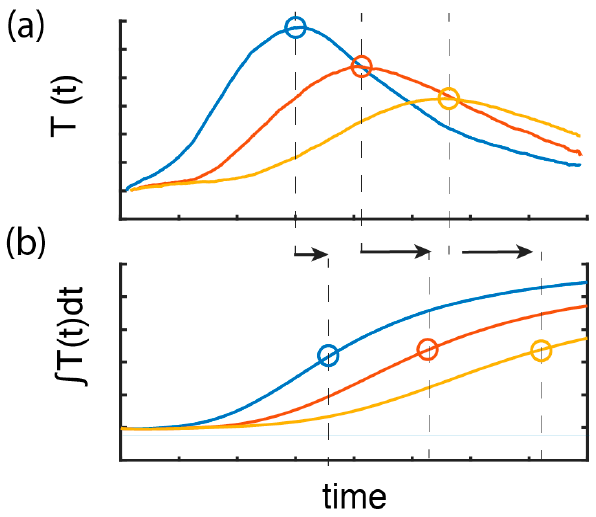
Figure 3. Description of two methods to estimate flow velocity. ( a ) Temperature profiles T ( x , t ) measured at three different fiber locations, indicating that the peak temperature can be tracked over the time–distance domain to extract the flow velocity. Convective heat transport distorts the symmetry of the heat pulse propagating downstream; therefore, this method results in a significant underestimation of the flow rates. ( b ) The integral of the temperature profile over time for three different fiber positions, from which the “center of heat” is obtained as the time when the integral of T ( x , t ) reaches half the maximum value for each position. Tracking this center point gives information of the propagation of the centroid of the thermal energy pulse. The black arrows highlight the difference between the identified times to calculate flow rates.